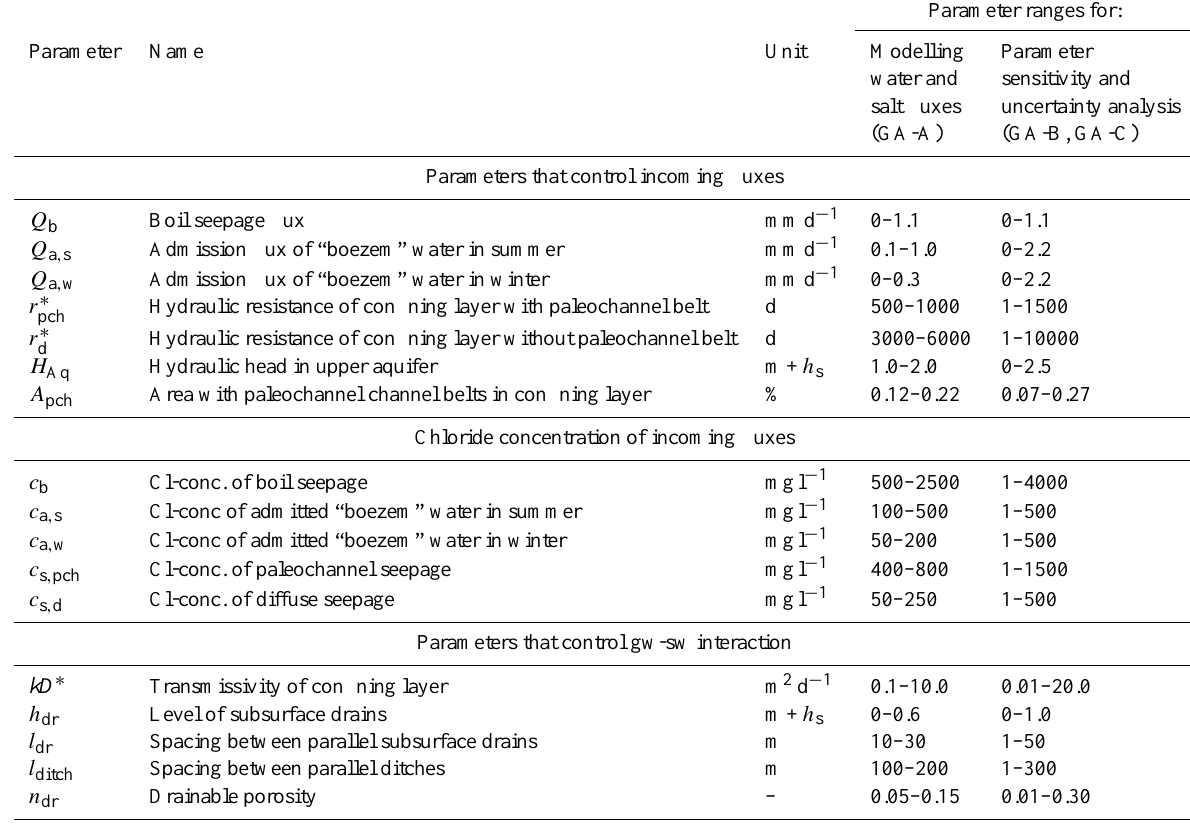
Parameter ranges for: